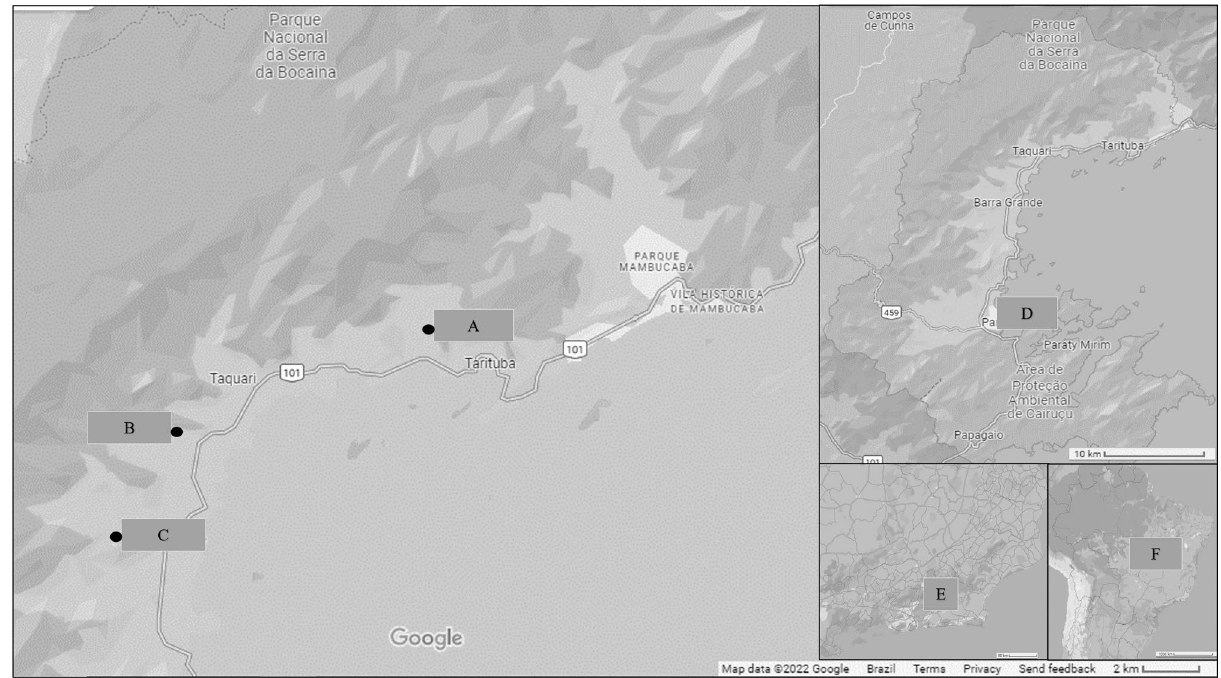
Figure 1. Satellite Image of the Study Area, in the neighborhoods of São Gonçalo ( A ), São Roque ( B ) and Barra Grande ( C ), Municipality of Paraty ( D ), State of Rio de Janeiro ( E ), Brazil ( F ). Map data ©2022